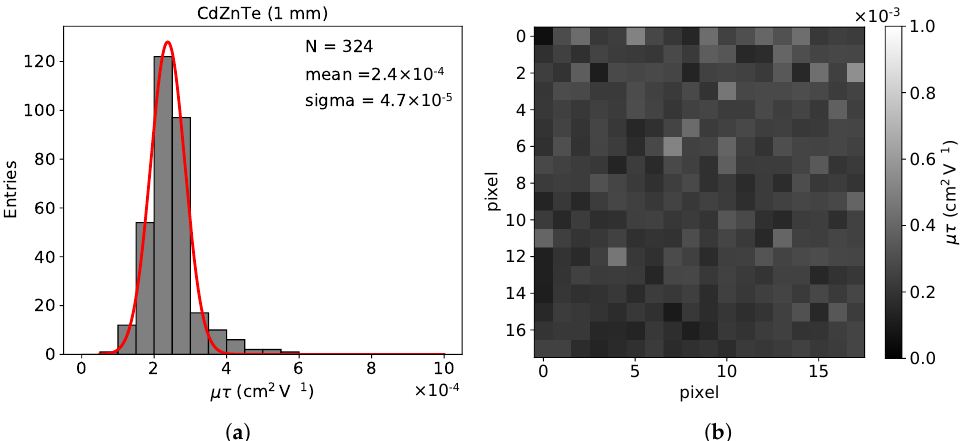
Figure 9. ( a ) The measured values of the mobility-lifetime product of electrons µ e τ e , for all the pixels within a 1 mm 2 area of the 1 mm thick CdZnTe sensor. ( b ) The corresponding 2D histogram showing the